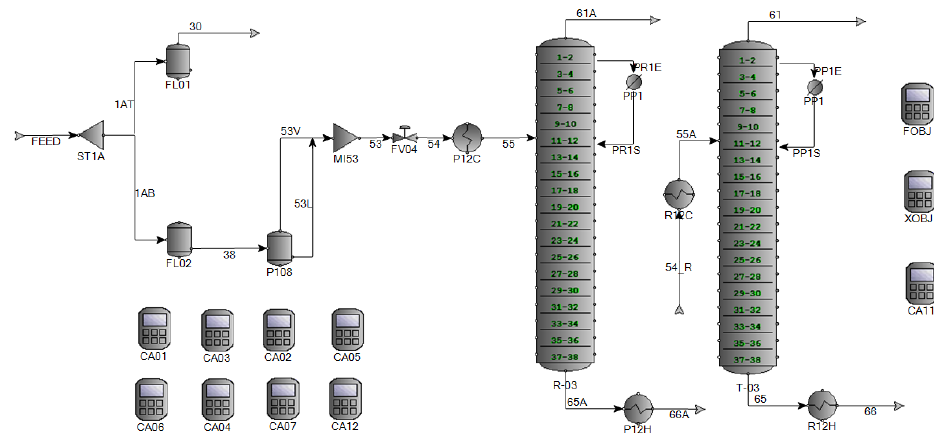
Figure 4. Flow sheet of the process model in